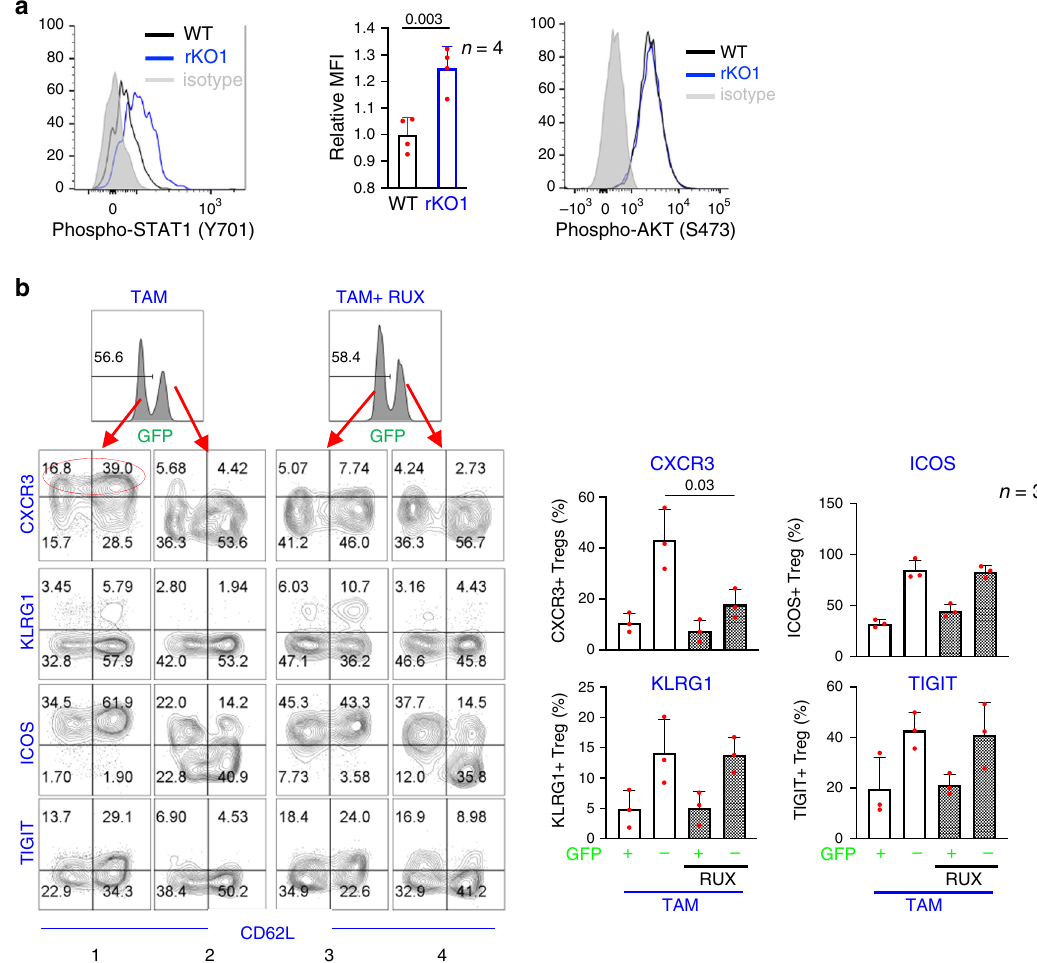
Fig. 4 Enhanced Stat1 signaling helps BRG1 drive CXCR3 overexpression. a STAT1 and AKT signaling in splenic Tregs. To quantify STAT1 (Y701) phosphorylation, the STAT1 (Y701) MFI for rKO1 Tregs was normalized to the WT controls, the latter set as 1 (middle, where the values represent mean ± SD, n = 4). b Selective inhibition of CXCR3 expression by Ruxolitinib (RUX). Representative FACS plots were shown at the left (CXCR3 + Tregs in Brg1- reexpessed cells circled) and data displayed at the right. Cells were stained and analyzed as in Fig. 3e. Of note, RUX also appeared to affect CXCR3 in Brg1 - deleted Tregs, but the effect is hard to quantify because CXCR3 expression was too